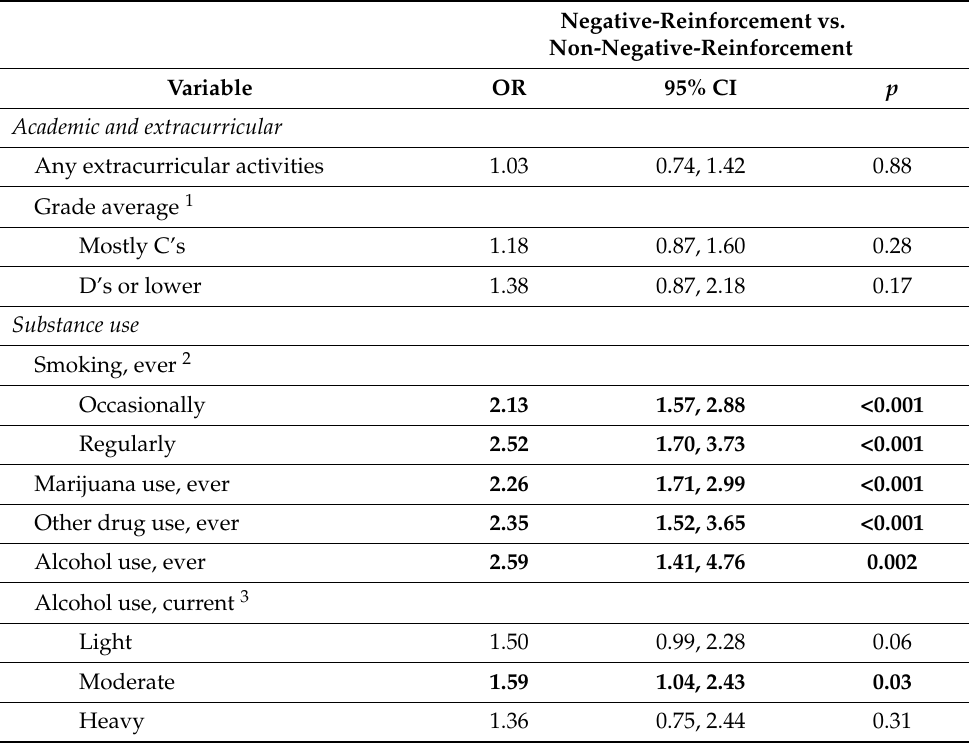
Table 2. Health correlates stratified by negative-reinforcement-shopping status (odds ratio). Negative-Reinforcement